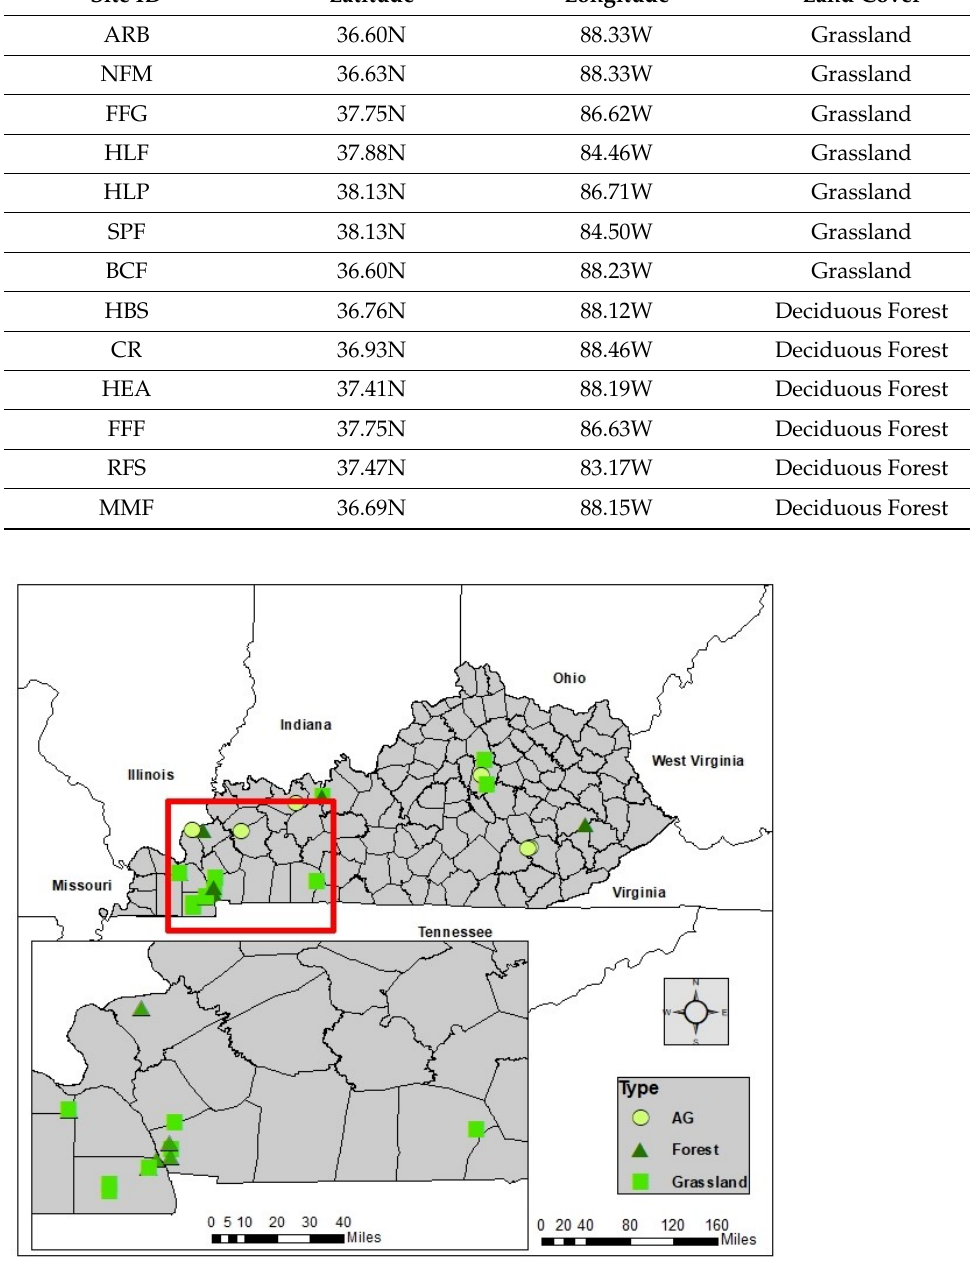
Figure 1. Location of the 19 study sites and their land cover types in our study region, (Kentucky,